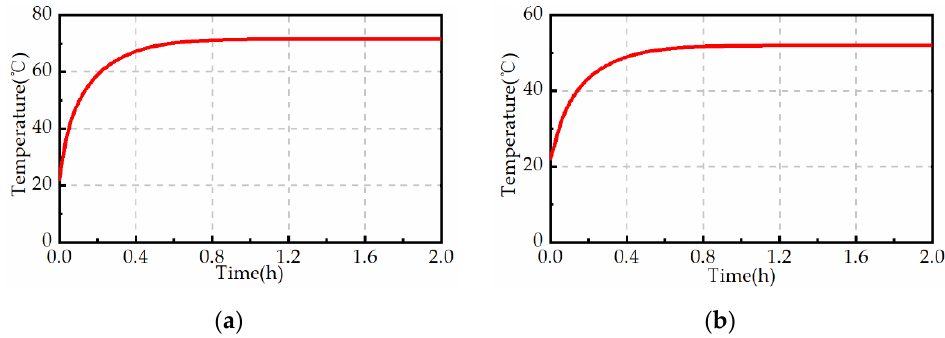
85.311 °C and 44.471 °C, respectively, which is 10.08% and 44.49% lower than that in Fig-